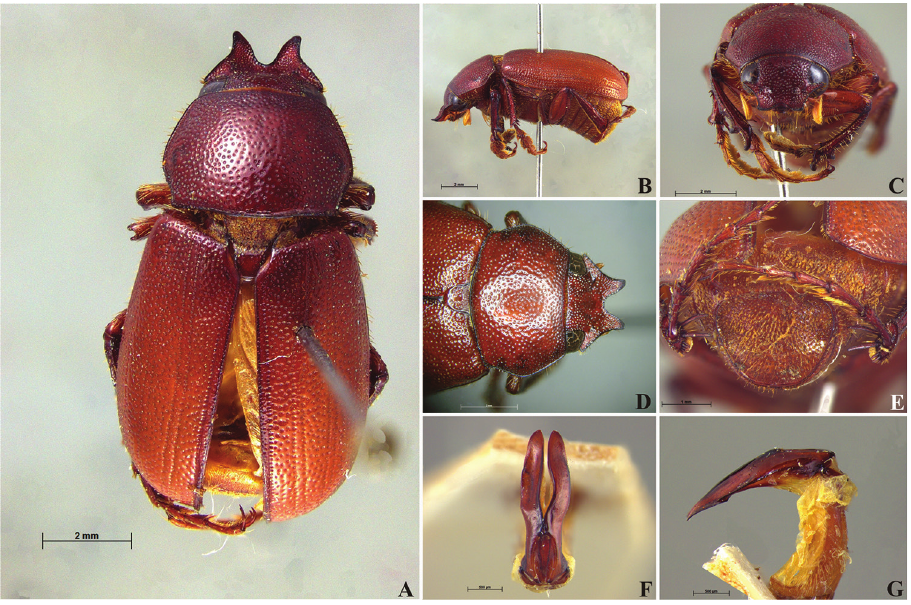
Figure 59. Liogenys bilobata Frey. A Dorsal view B Lateral view C Frontal view D Clypeus and prono- tum E Pygidium F Parameres, dorsal view G Parameres, lateral